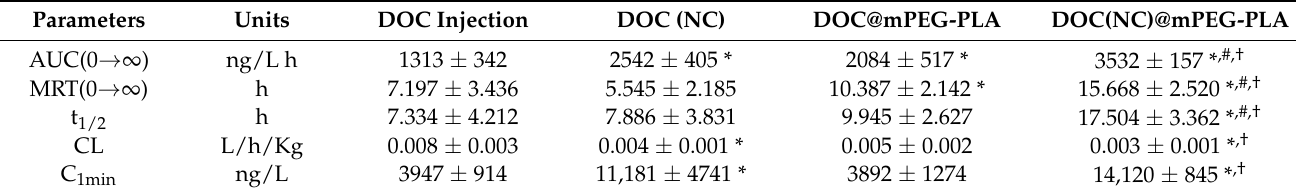
Table 2. Pharmacokinetics parameters of different formulations on rats via intravenous route at 10 mg/kg (mean ± SD, n = 5).